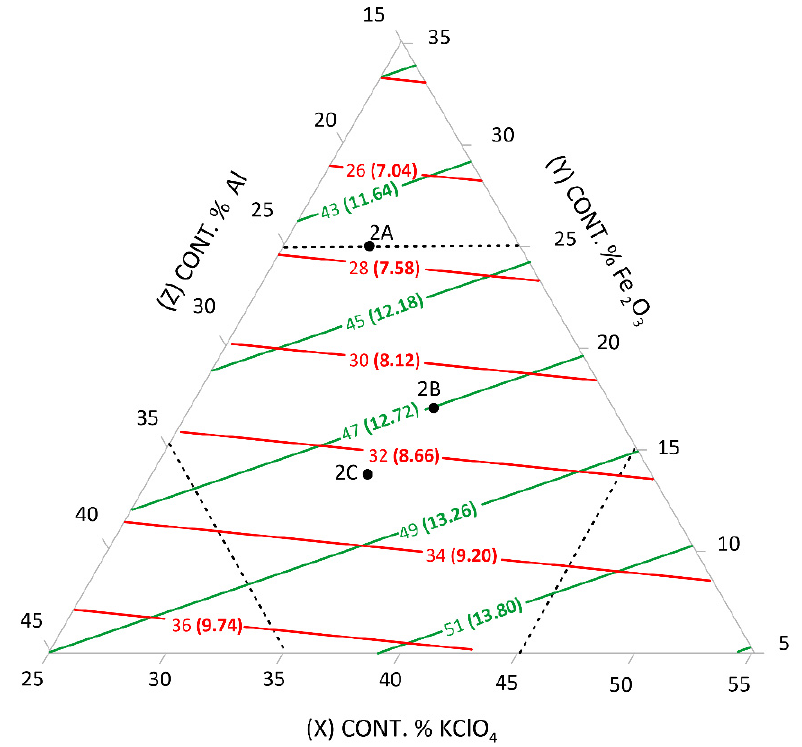
Figure 2. Relationship between costs of the composition (USD/kg): red line—1981, green line—2021; and the content of pyrotechnic composition components (%). Sides of the triangle, with fixed sulphur content S = 25%.